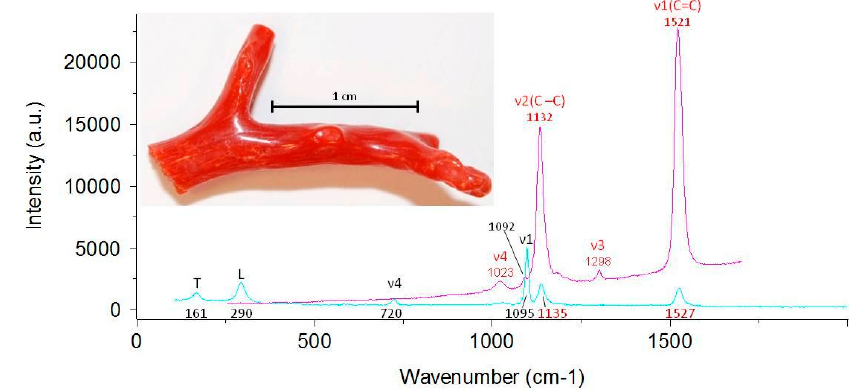
Figure 1. Raman spectrum of the same spot of a C. rubrum sample using 785 nm (blue) and 488 nm (red), indicating the visibility of different features of C. rubrum . Abbreviations: T = translation; L = libration; ν 4 = in-plane bending; ν 1 = symmetric stretching.